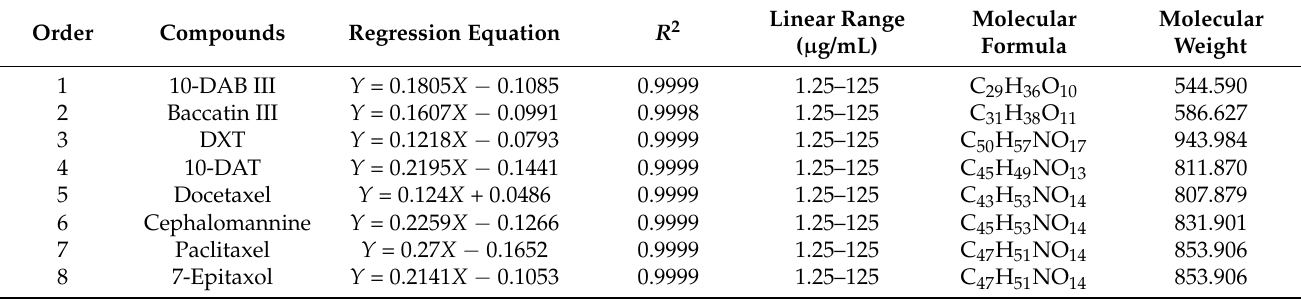
Figure 2. High-performance liquid chromatogram (HPLC) of the eight taxanes: ( a ) standard sub- stance, ( b ) real sample of extract. Table 2. Regression equation, linear range, structural formula, and molecular weight of mea- sured